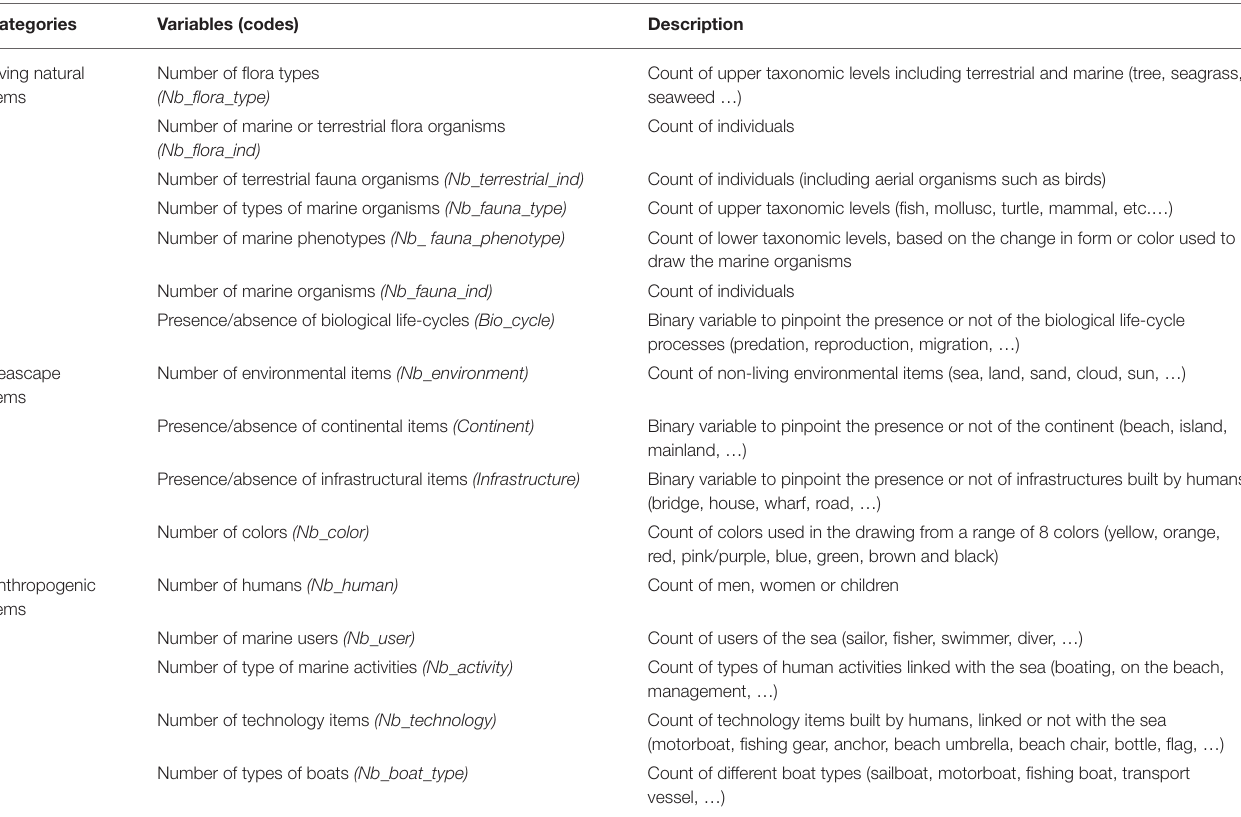
TABLE 3 | List of drawing descriptors (categories, variables) used to assess the representations of sea or coral